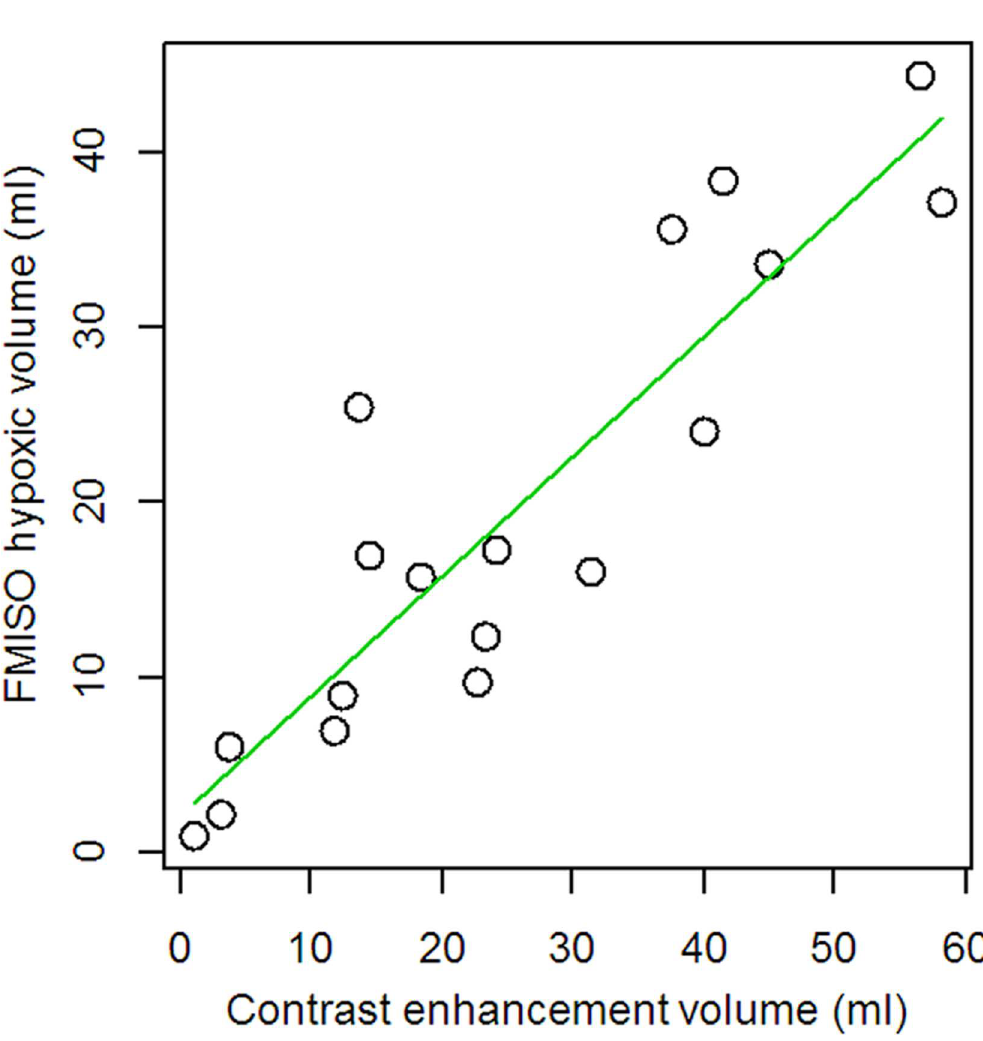
Fig 1. Correlation between contrast-enhanced tumor volumes and FMISO hypoxic volumes before BEV treatment. There are strong positive correlationbetweenthese two volumetricvalues ( r = 0.89, P <